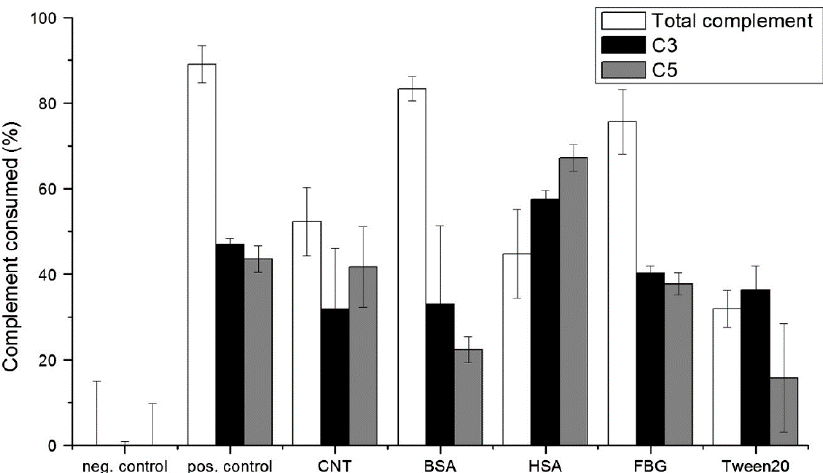
Figure 8. Complement consumption for total complement and C3 and C5 components induced by double walled-CNTs (DWCNTs)—pristine or coated with various plasma proteins (BSA, HSA, FBG) or Tween 20. All the CNT samples tested activated complement predominantly through the classical pathway and consumption up to C5 indicated potential formation of the Membrane Attack Complex.